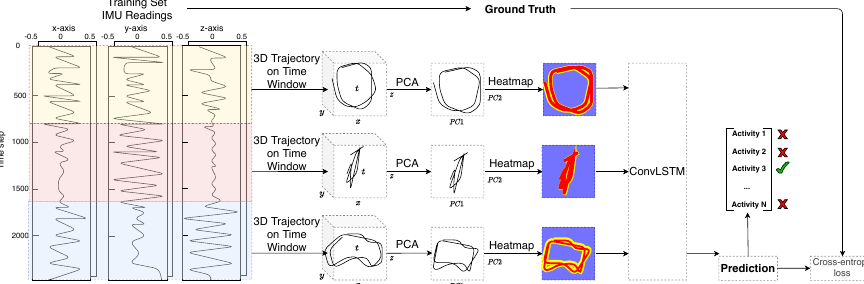
Figure 2. Overview: Left: implementation pipeline of modality transformation from 1D IMU data for given time windows into 3D trajectories. Middle: generating 2D heatmap images from 3D trajectories via deep inertial poser. Right: classification with